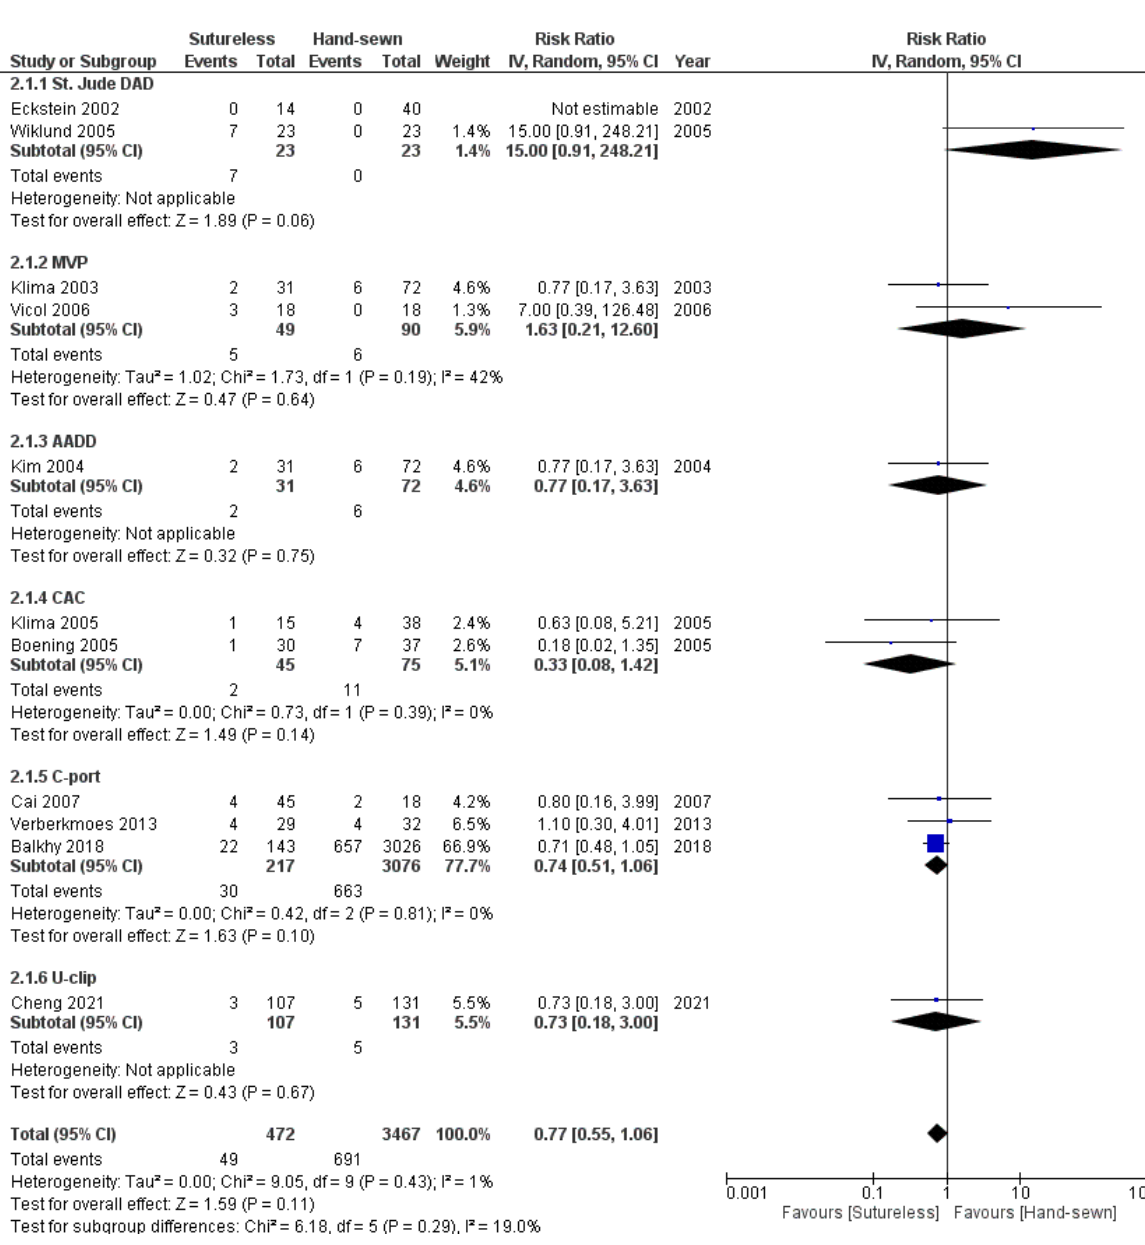
Figure 3. Forest plot on anastomotic patency, presented per device subgroup. Line of no effect represented by vertical line. Outcome measures for individual studies are presented per box (risk ratio) and horizontal line (95% confidence interval). The summary outcome per device group and for the total group is presented in a diamond shape (risk ratio and 95% confidence interval).